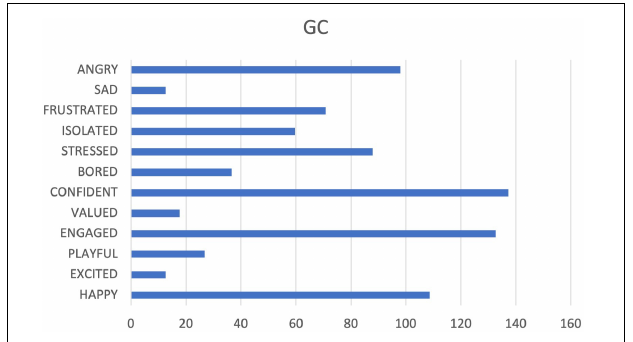
FIGURE 10 | Cumulative frequencies of GC data